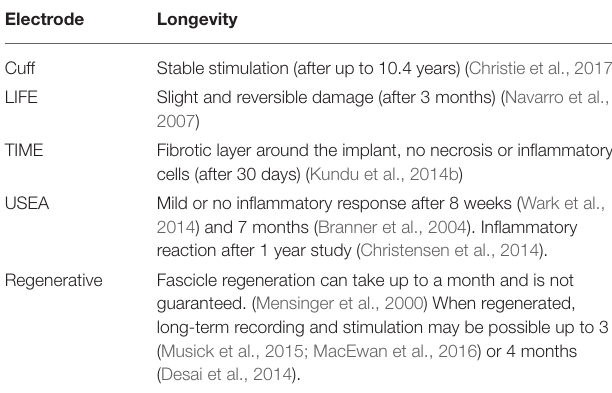
TABLE 1 | Comparison of the longevity of the discussed electrodes. Electrode